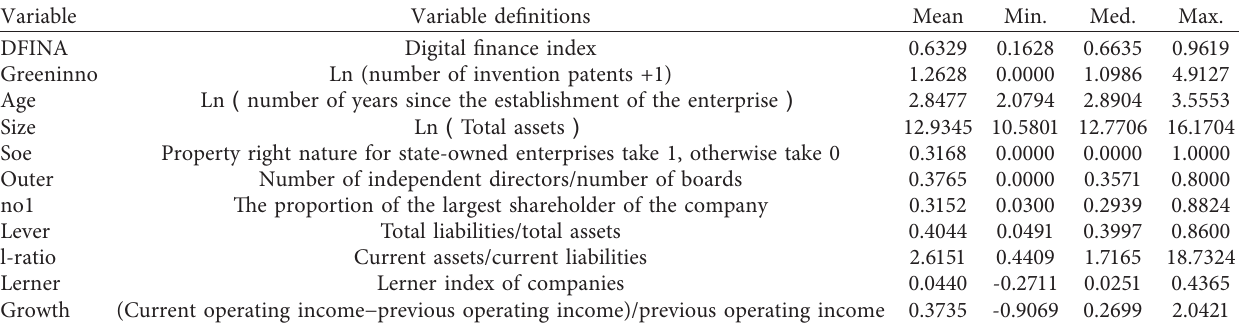
Table 1: Descriptive statistical analysis of the main variables.